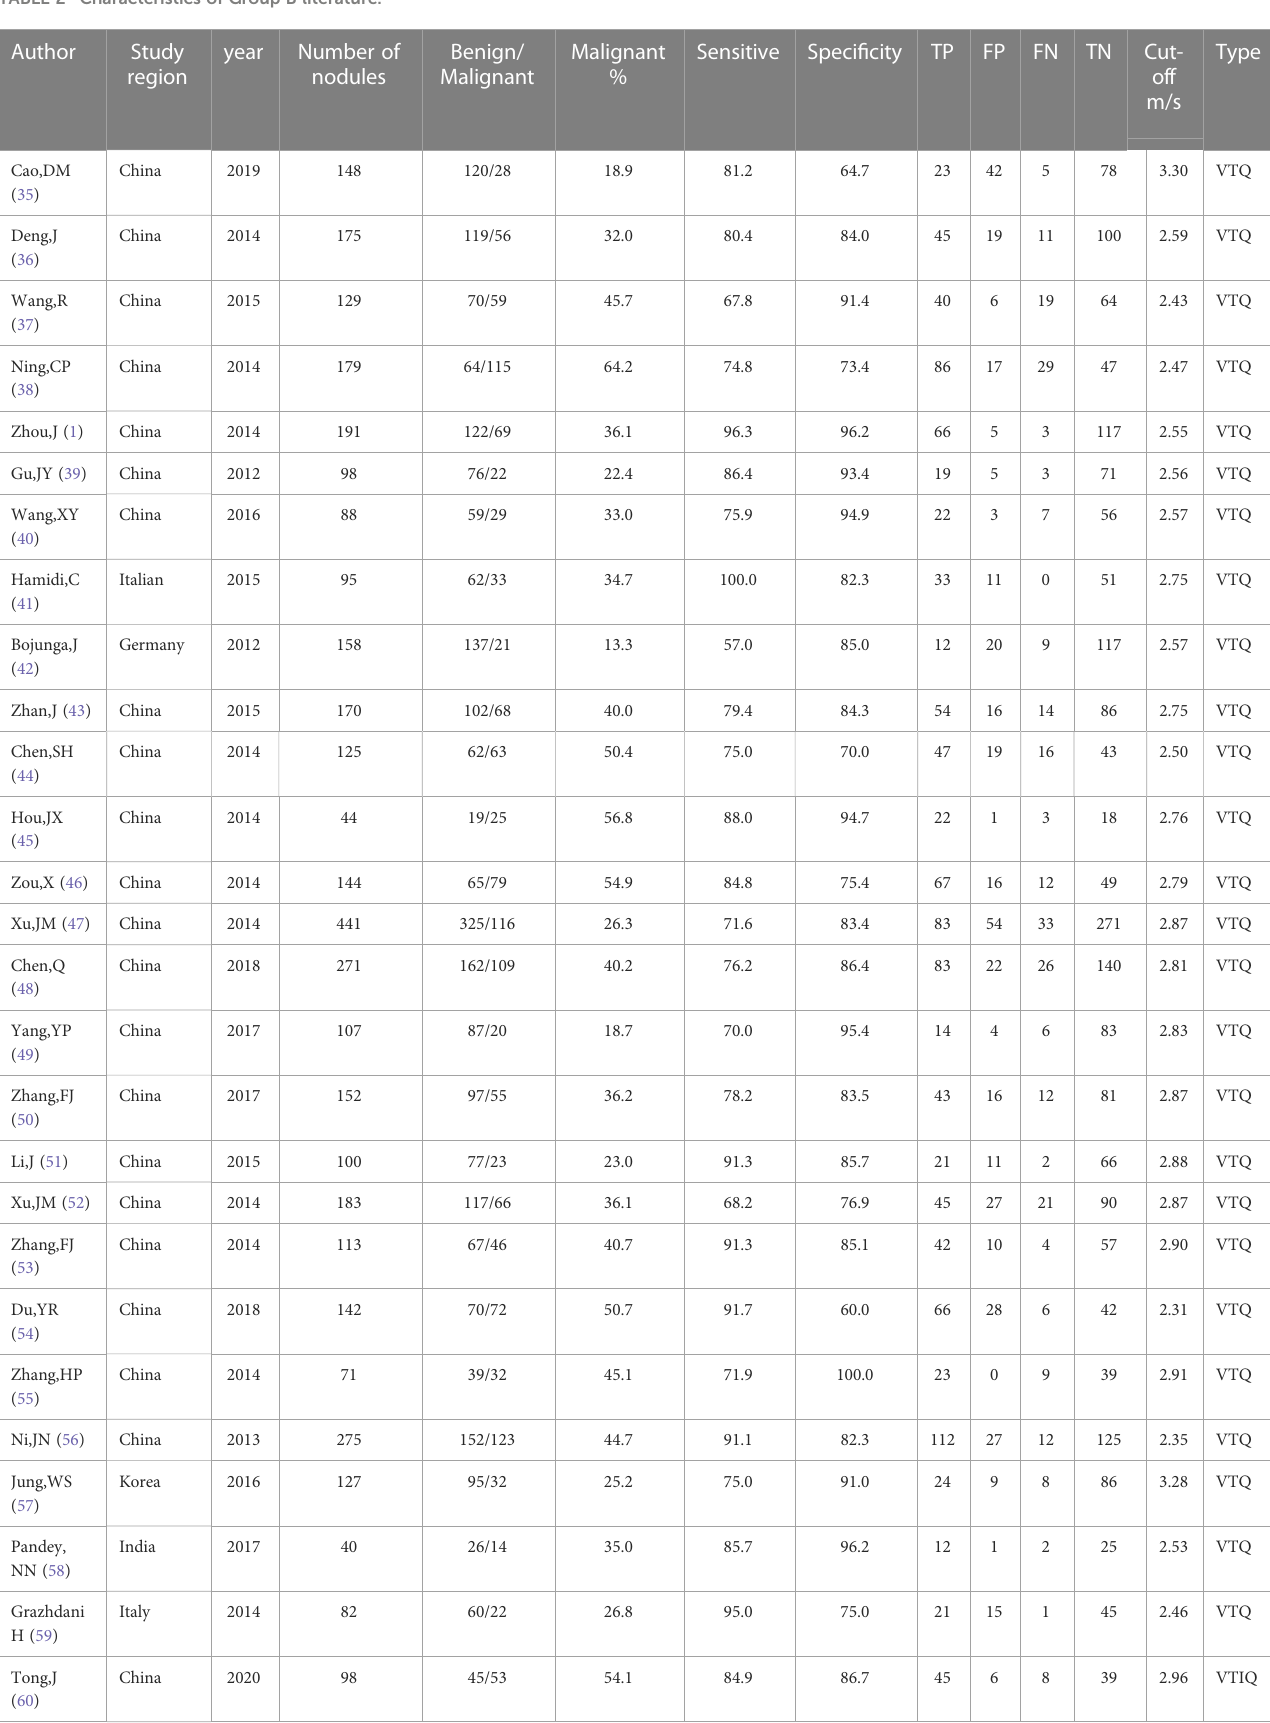
TABLE 2 Characteristics of Group B